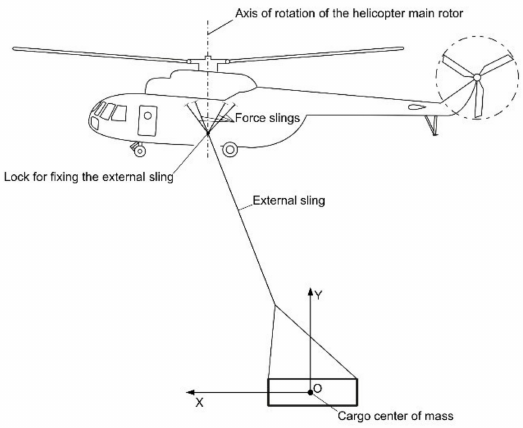
Figure 1. Helicopter with cargo on the external sling.